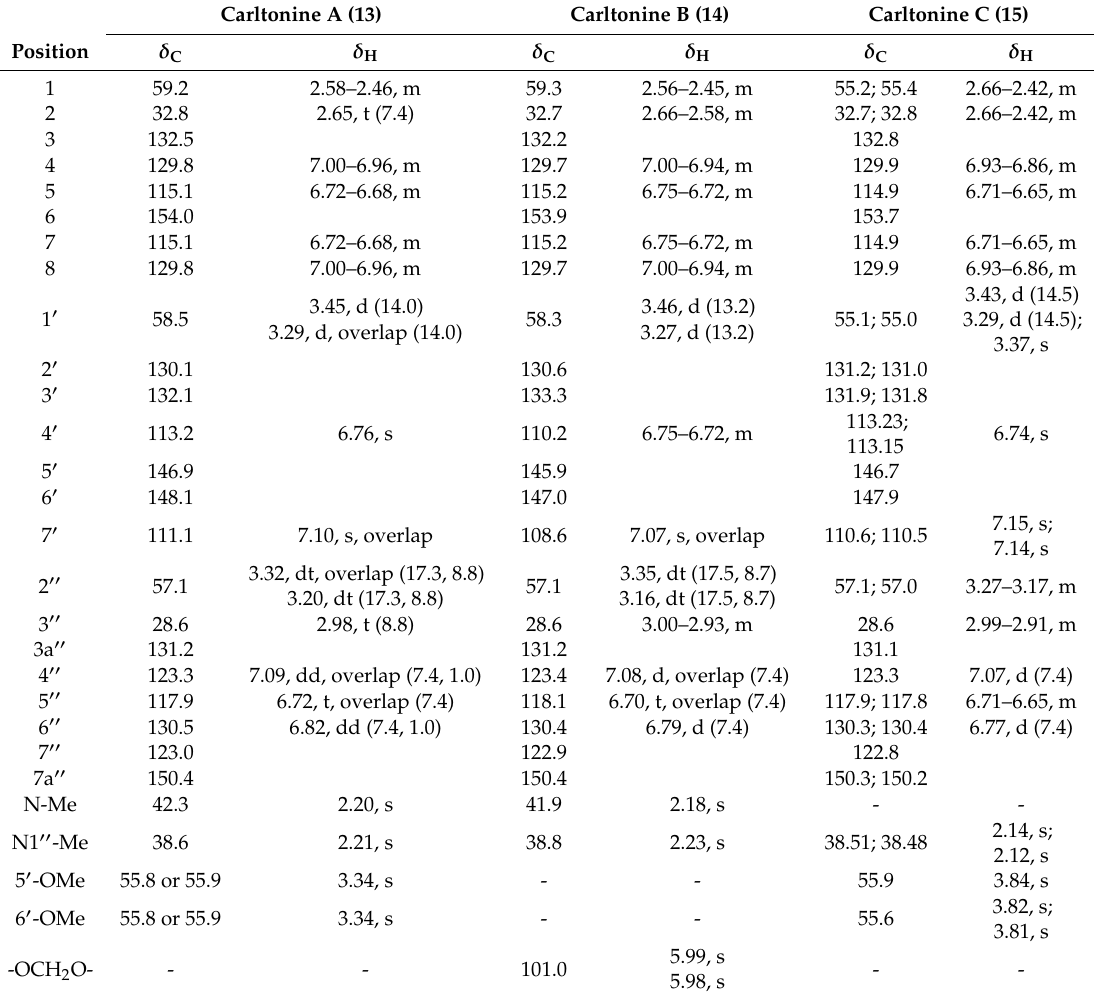
Table 1. 1 H NMR (500 MHz) and 13 C NMR (125.7 MHz) data for 13 – 15 in CDCl 3 ( δ in ppm and J in